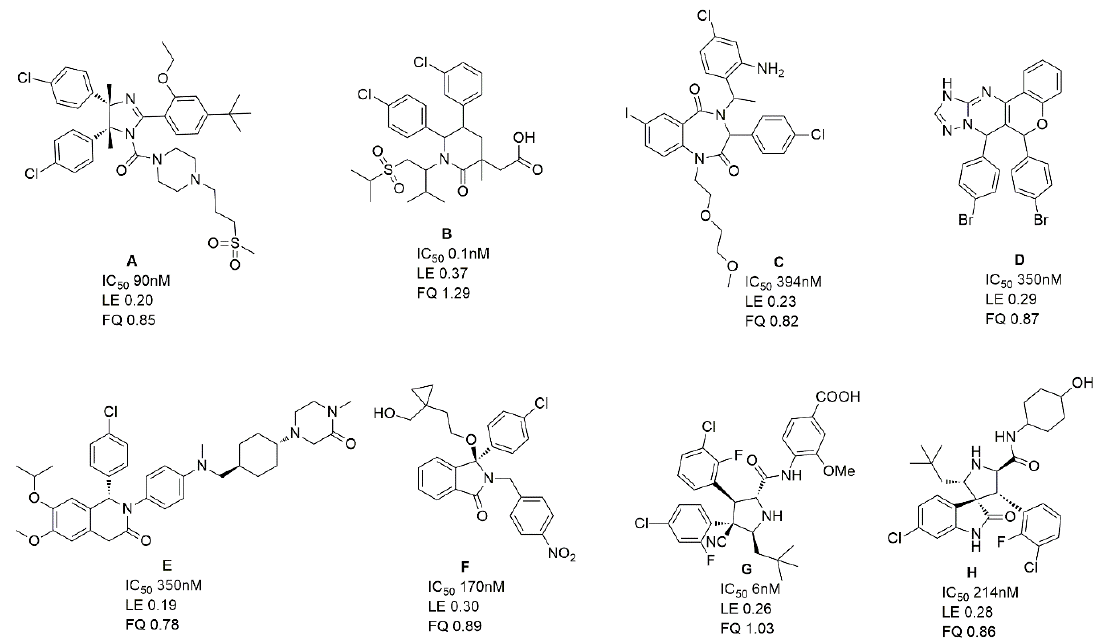
Figure 9. The chemical structures, LE and FQ of eight groups of MDM2/P53 PPIIs used in this study.